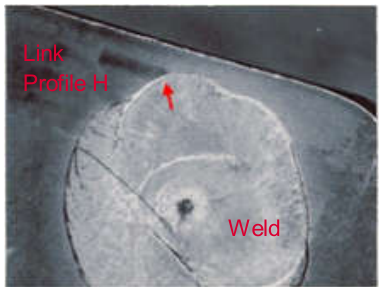
Figure 33. Corrosion at the laser weld/link interface. Optical examination, magnification 5×. Link sample #4 and pin sample #3.